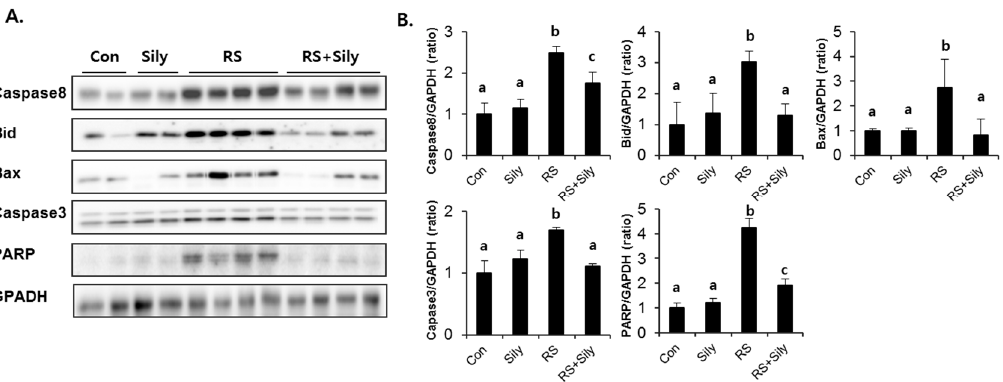
Figure 6. Silymarin treatment reduced restraint-induced apoptotic cascade. ( A ) Immunoblot analysis of caspase8, Bid, Bax, caspase3, PARP, and GAPDH. ( B ) Quantitative analysis of blots. Each value is the mean ± SD for four mice. Values with different letters (a, b) are significantly different from one another (one-way ANOVA followed by Newman-Keuls multiple range test, p < 0.05). CON; control mice, Sily; only silymarin-treated mice, RS; restraint stressed mice, RS + Sily; restraint-stressed mice with silymarin treatment.